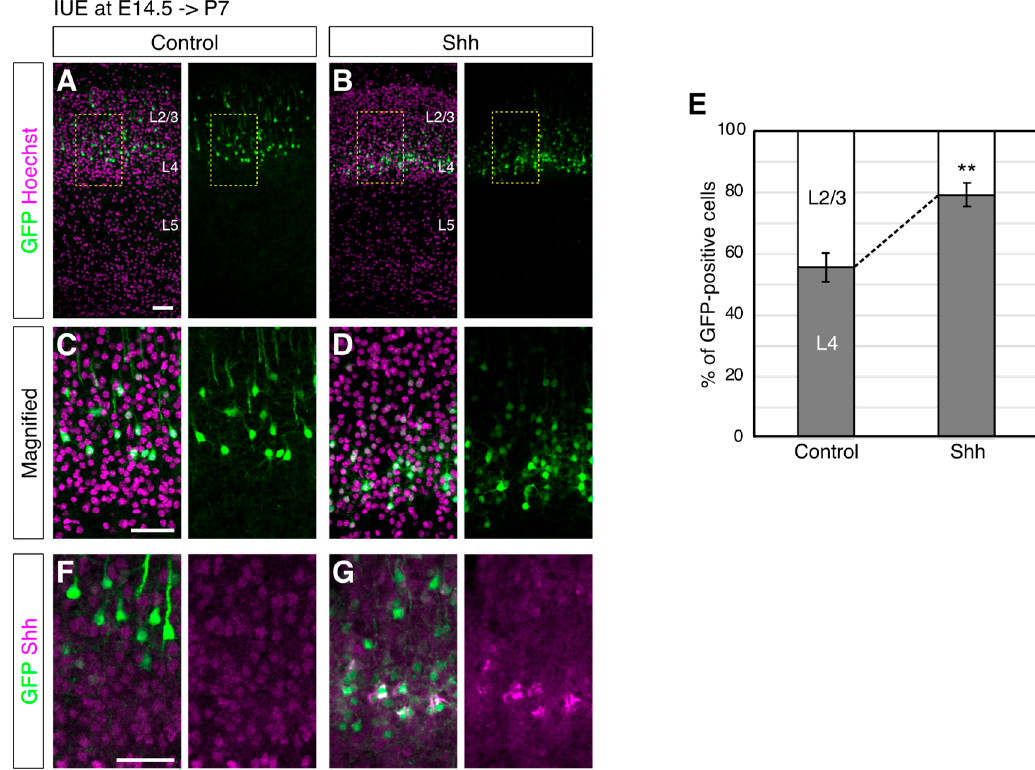
Figure 1. Shh overexpression at E14.5 increases the percentage of neurons in L4 at P7. ( A , B ). Empty (Control, ( A )) or Shh expression vector (Shh, ( B )) together with a GFP vector was electroporated into E14.5 brains, and then P7 brains were analyzed. The sections were counterstained with Hoechst (magenta). The boxed regions are shown at higher magnification in ( C , D ). ( E ). The percentages of the cells in L2/3 and L4 were determined in each condition. Quantitative data are presented ( n = 3 for each group). ** p < 0.01. Note that the GFP-positive cells with Shh expression vector are located more in L4 than the control cells. ( F , G ). Expression of Shh was shown in the neurons treated as in ( A , B ). (Scale bars: 200 µm in ( A , C , F )).